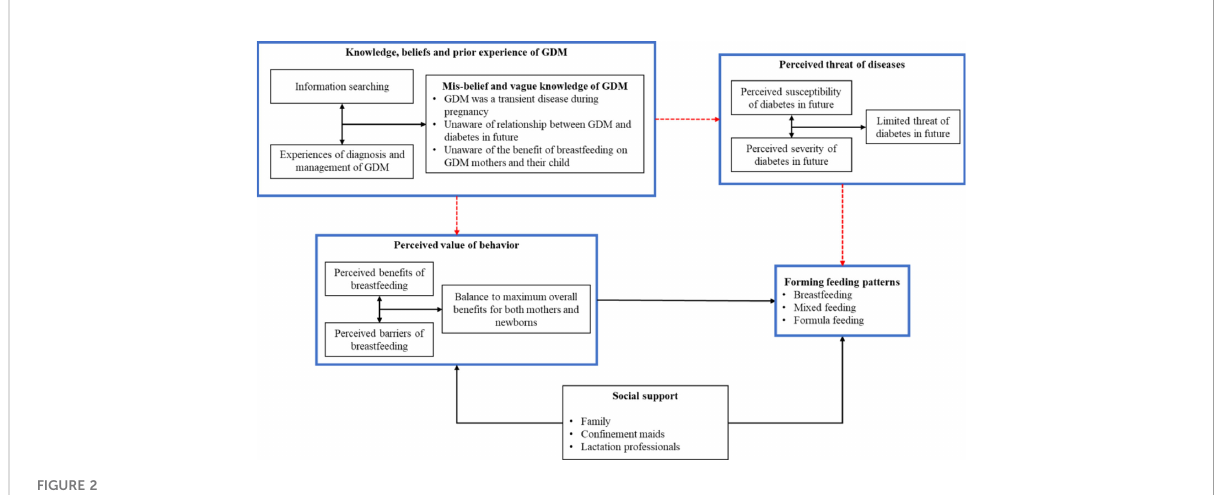
FIGURE 2 Decision-making process of GDM mothers ’ feeding